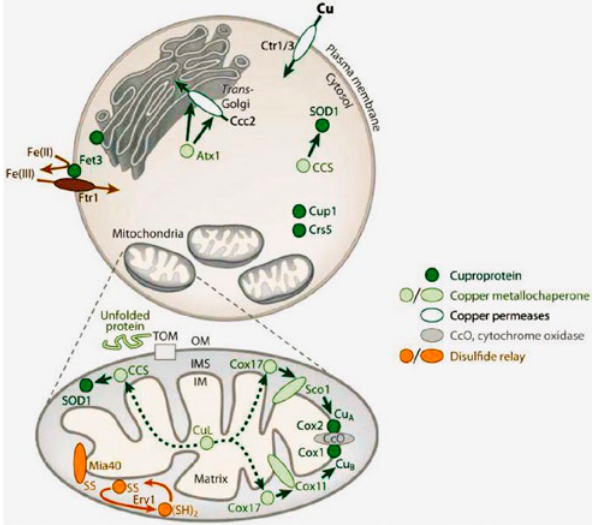
Figure 14. Diagram of copper eukaryoyic cellular distribution. See text for explanations.